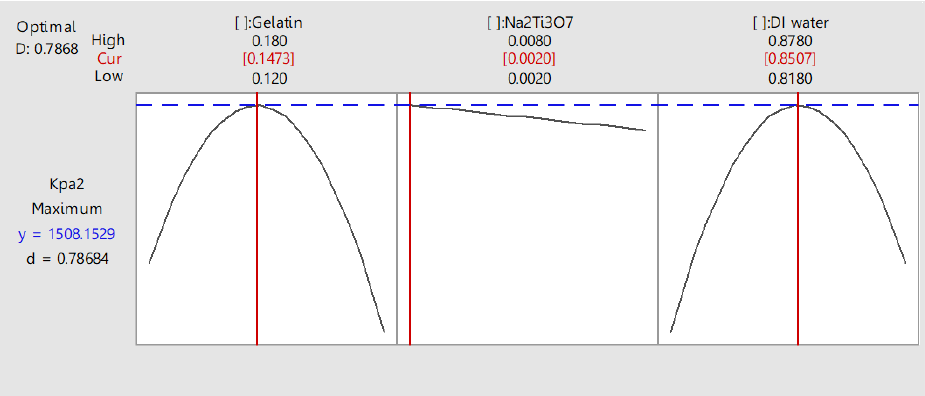
Figure 3. Multiple response prediction.